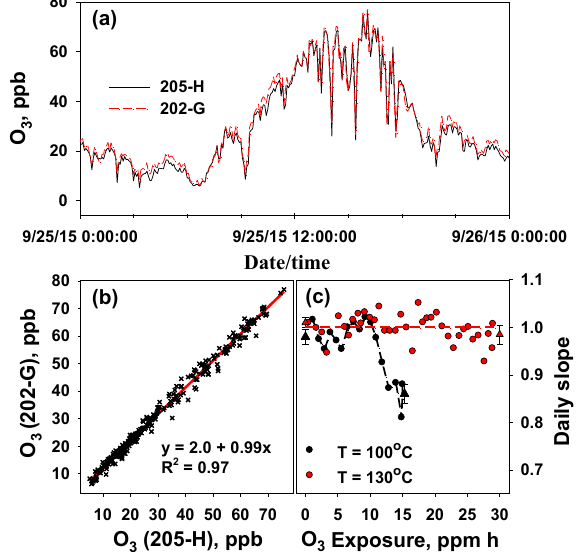
Figure 3. (a) Time series of 5min averaged ozone concentrations measured in Boulder, CO, on 26 September 2015. (b) Correla- tion plot between the Model 202 (202-G, equipped with graphite scrubber) and the FEM Model 205 (205-H, Hopcalite scrubber and Nafion) for 26 September 2015. (c) Plot of the daily correlation plot slope vs. cumulative ozone exposure for the 202-G analyzer. Each point represents a single day. The graphite scrubber was initially maintained at 100 ◦ C, regenerated, and then operated at 130 ◦ C (see text for further explanation). Triangles represent calibration slopes pre- and